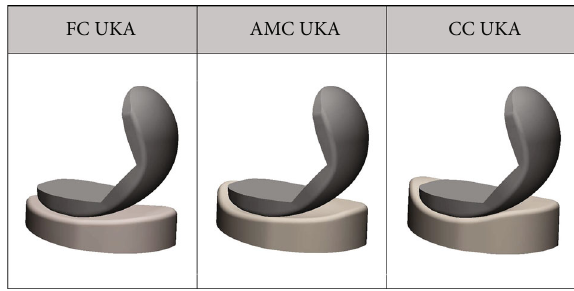
Figure 2: Cross-sections of the femoral component and tibial insert of the customized UKA used in this study, with three di ff erent